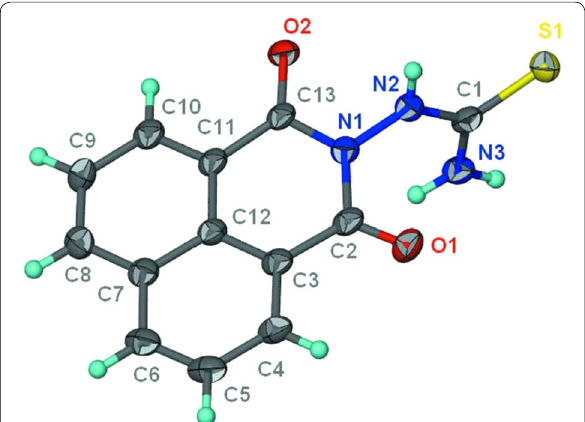
Fig. 2 ORTEP diagram of compound